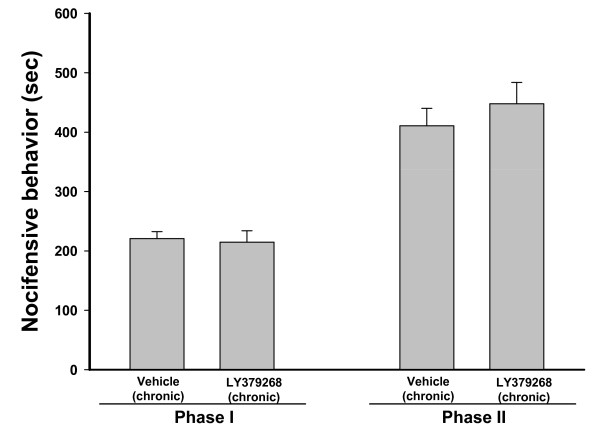
Loss of the analgesic effect of LY379268 in mGlu3-/- mice following repeated dosing. Vehicle or LY379268 (3 mg/kg, i.p.) were injected for 4 days every 24 hours in mGlu3-/- mice. On day 5 vehicle or LY379268 were administered 30 min before formalin injection. Data represent the mean ± S.E.M. of 8 to 12 mice. p > 0.3 vs vehicle group (t-test).